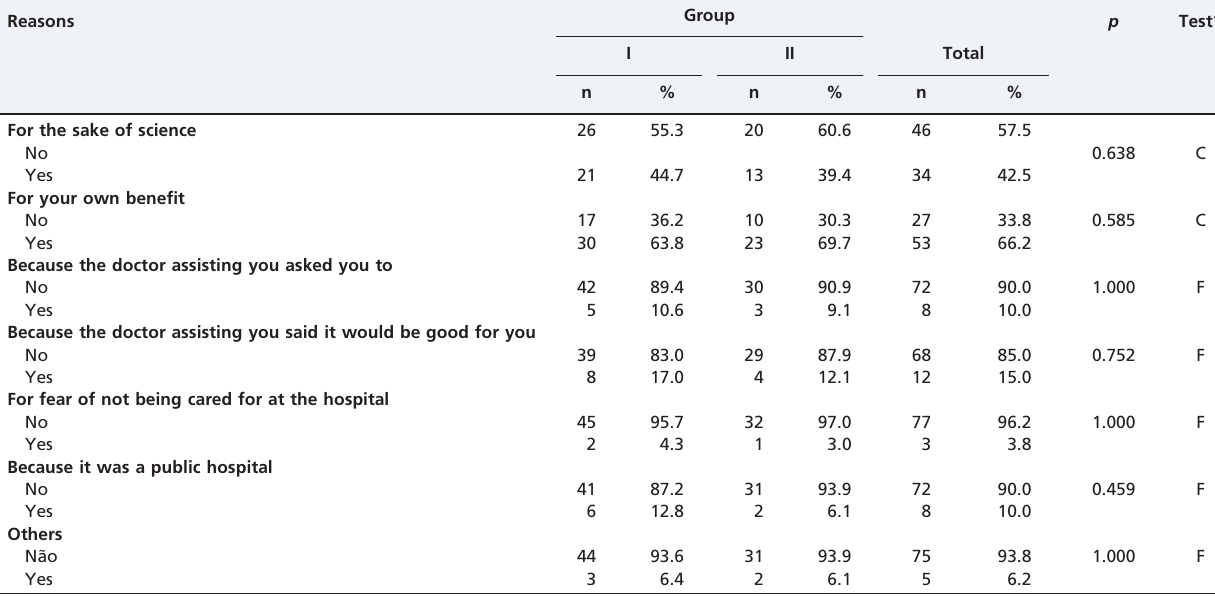
Table 2 - Factors associated with the decision to participate in the clinical trial. Reasons